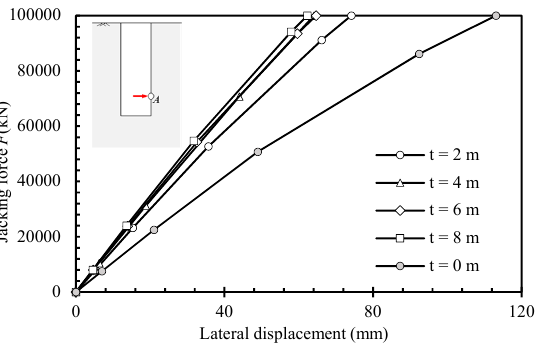
Figure 11. The load–lateral displacement curve of a caisson with different reinforcement thicknesses.